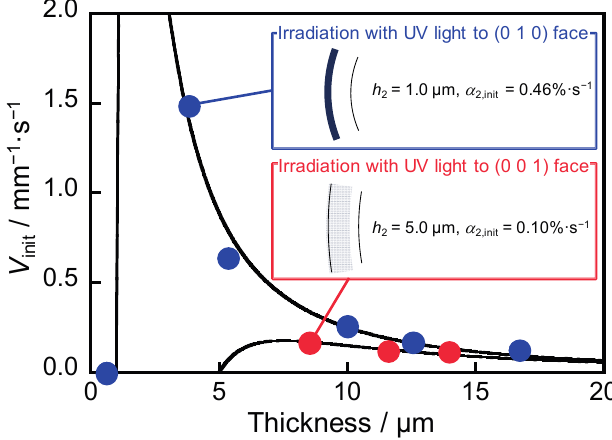
Figure 5. Initial speed of the curvature change relative to the crystal thickness with UV light irradiation to the (0 1 0) face (blue) and the (0 0 1) face (red) of diarylethene 1 . The solid lines show fitting curve using the bimetal model.